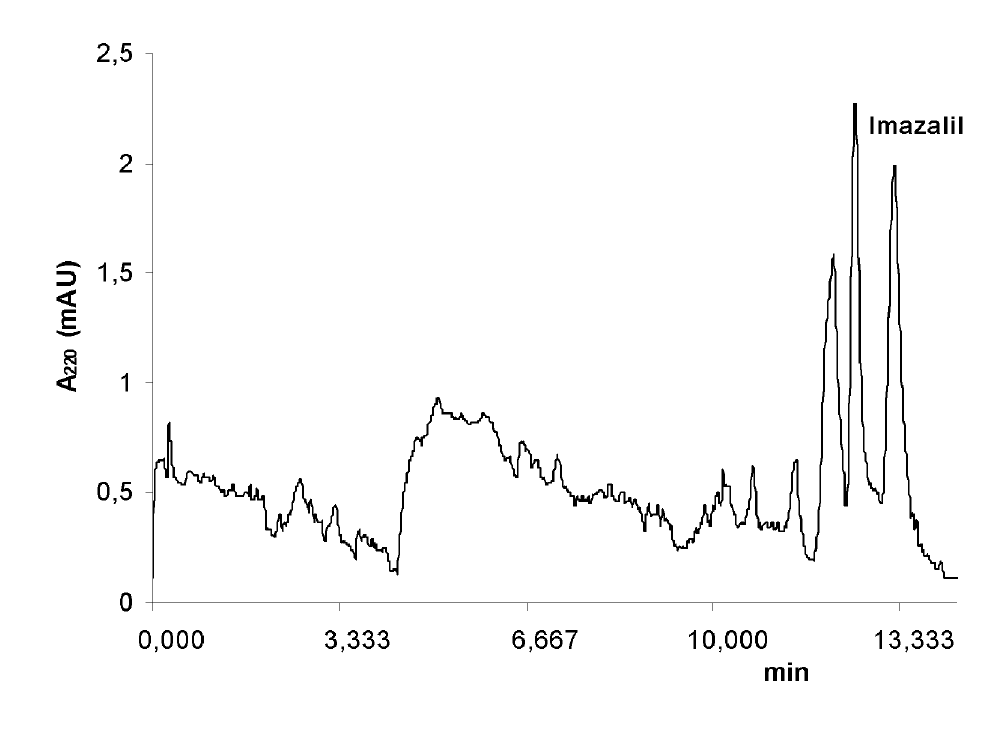
Fig. 4 Electropherogram of apple extract (spiked with 0.5 · g of IMZ.g ¡ 1 ) Time (hours)